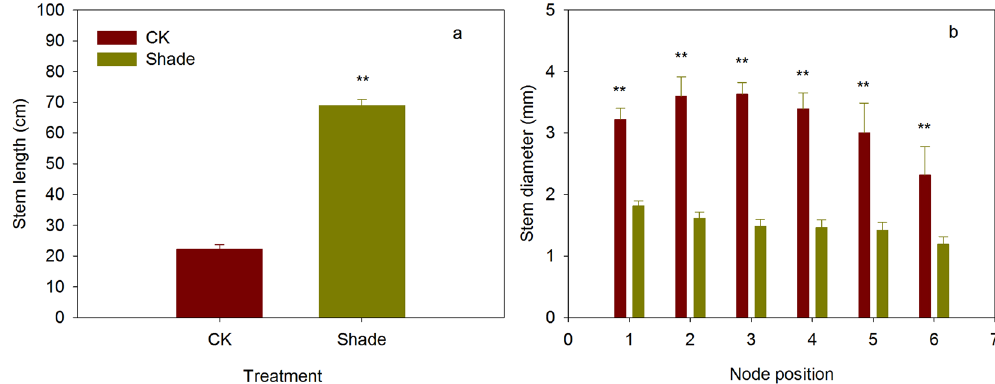
Figure 2. Stem length ( a ) and stem diameter ( b ) of soybean planted in shade and full sunlight (CK). Values are means ± SD (n = 4). Statistical significance assessed by Duncan’s t-test. ** indicates significant at 0.01 probability level, respectively.